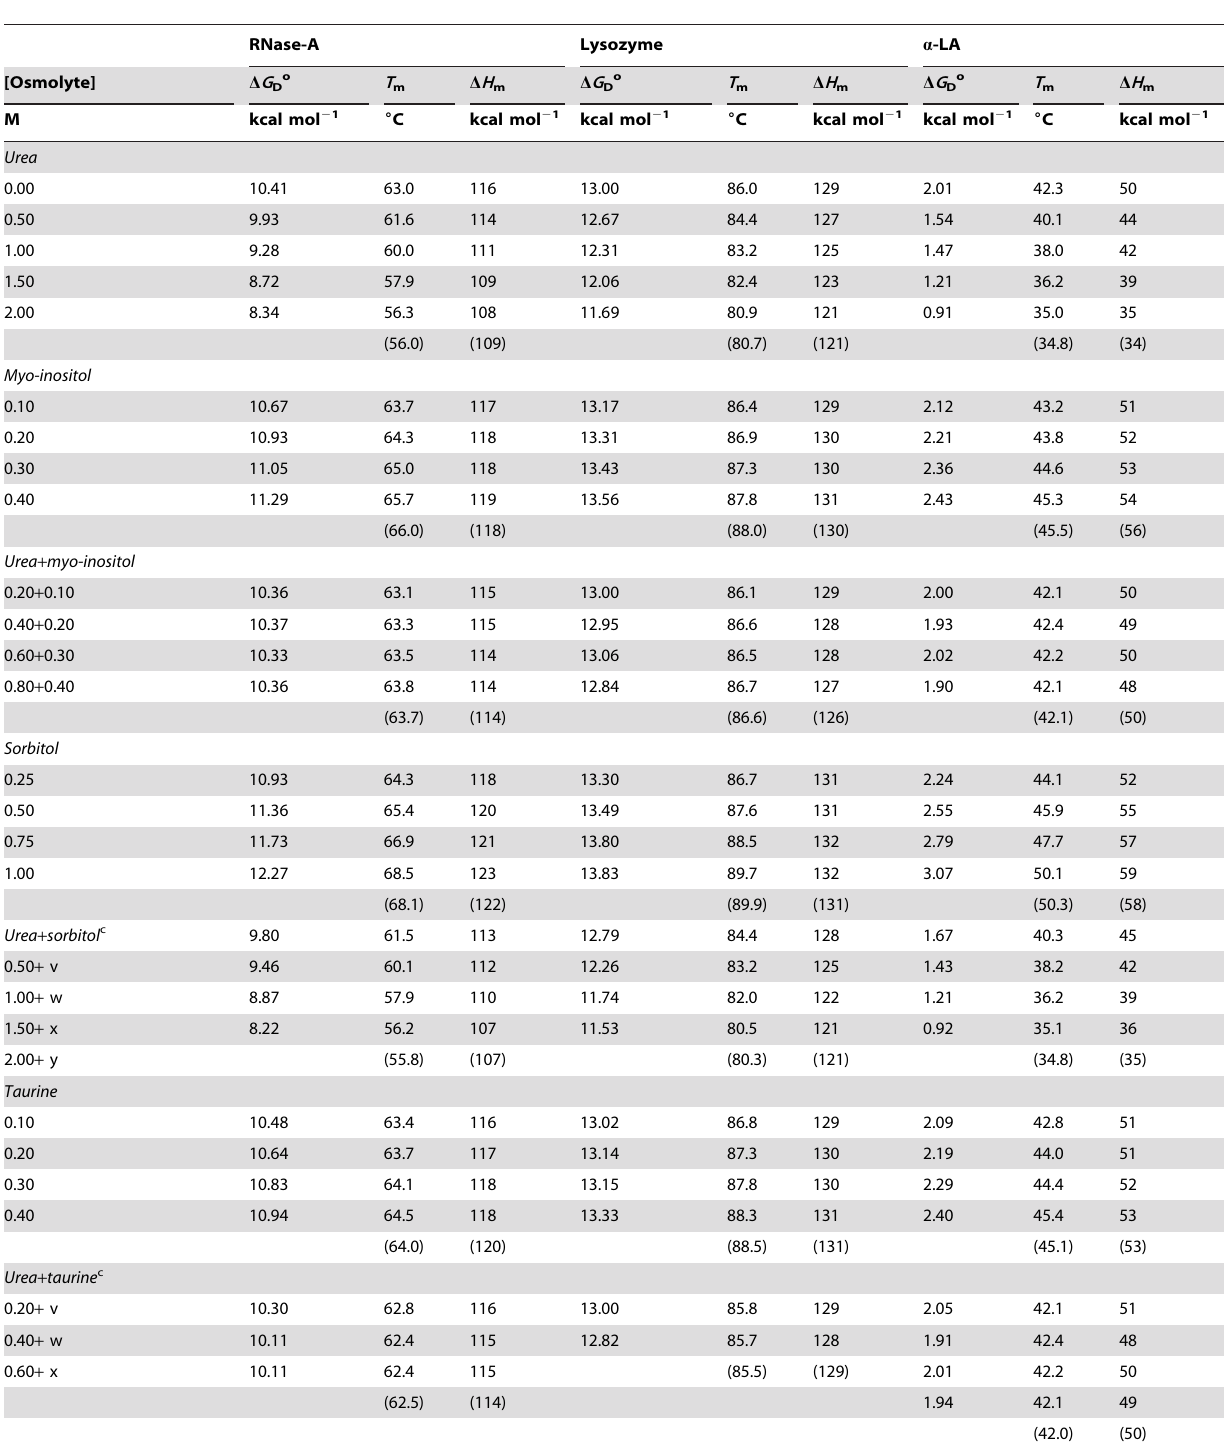
Table 1. Thermodynamic parameters associated with the thermal unfolding of RNase-A, Lysozyme and a -LA at pH 7.0. a, b, c.